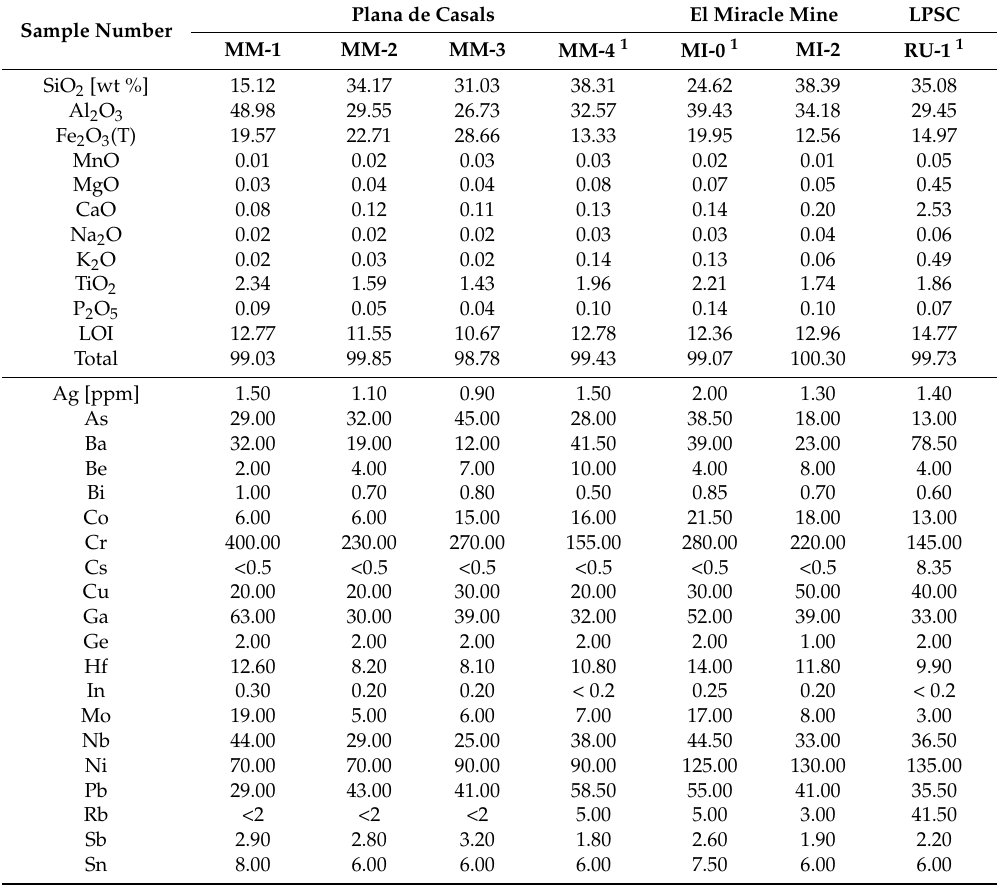
Table 2. Major-, minor- and trace-element (including REE) concentrations of the studied bauxitic samples from the